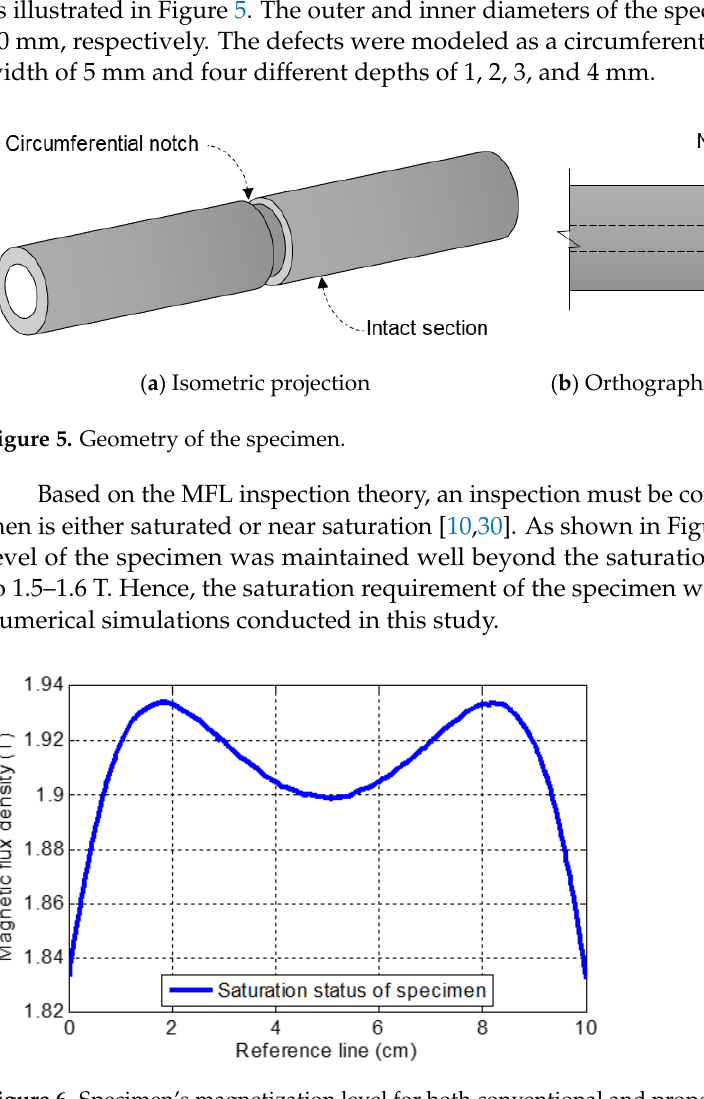
Figure 4. BH curve of low-carbon steel 1002 and 1006.